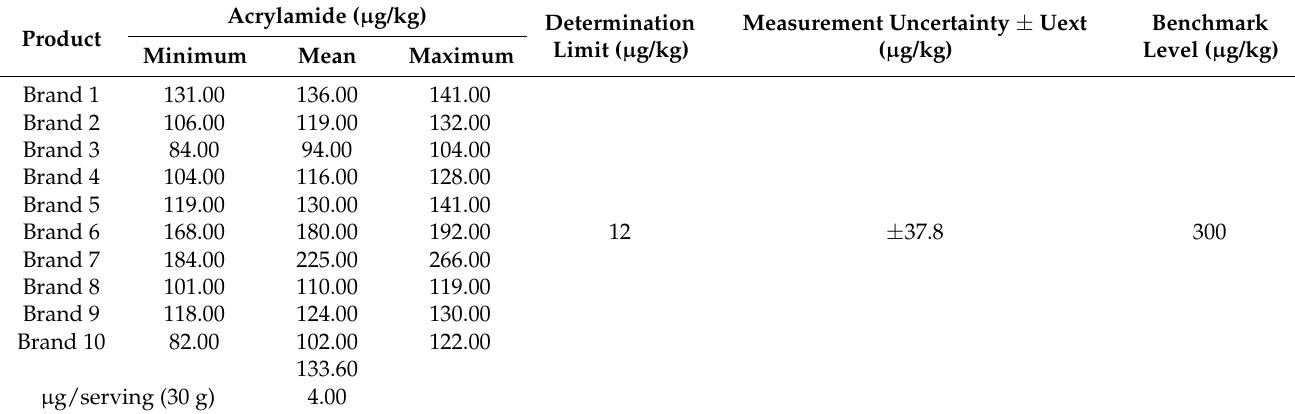
Table 5. The acrylamide level in potato chips ( µ